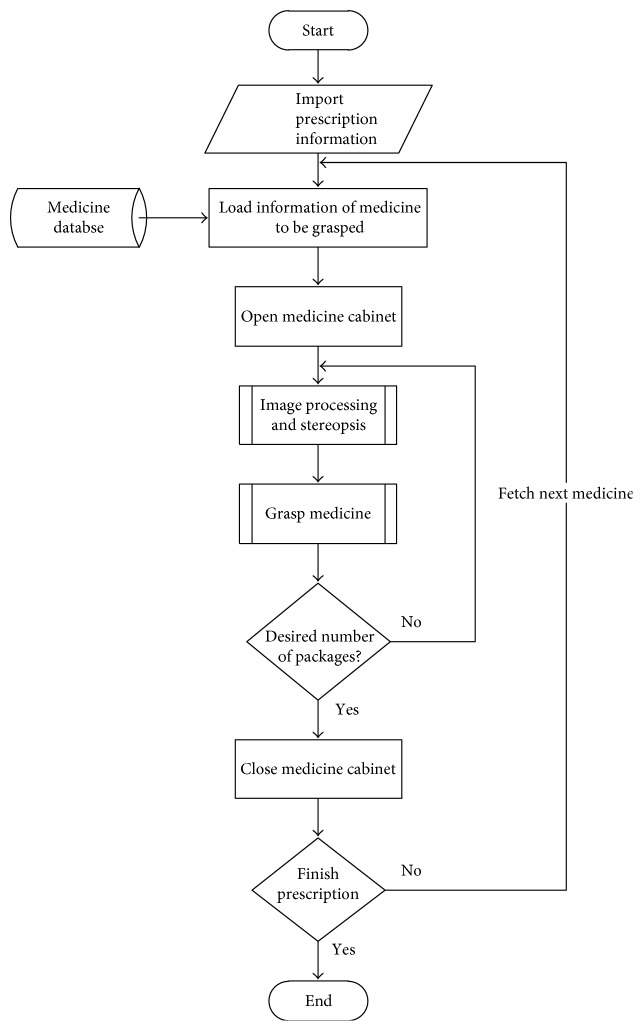
System flowchart.